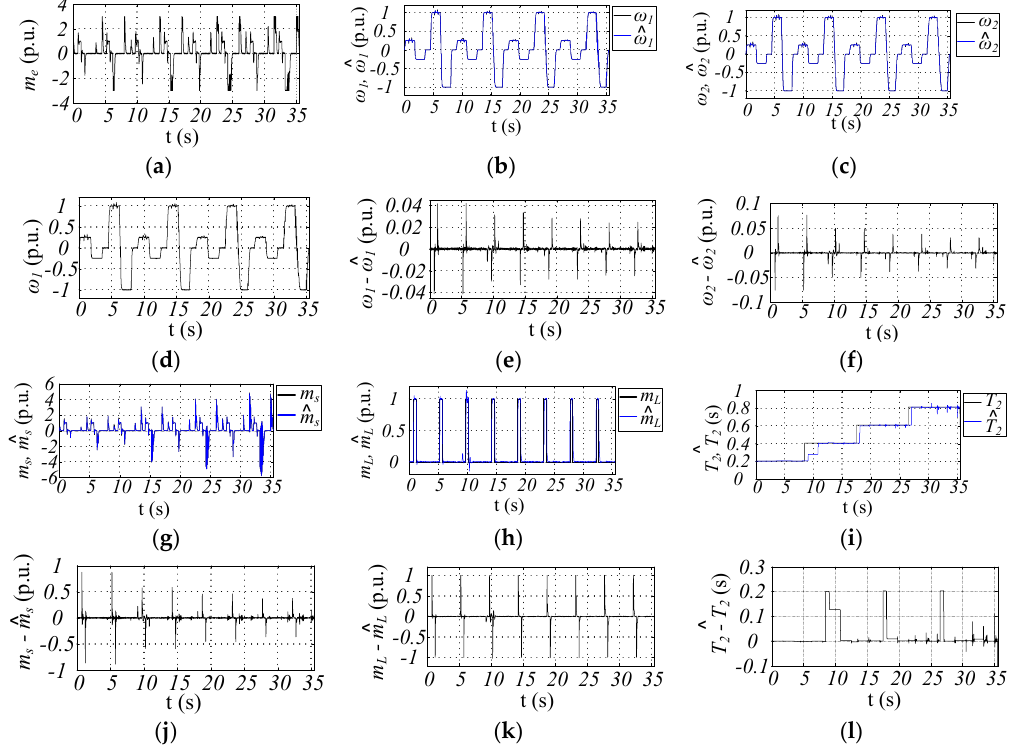
Figure 3. Transients process of the adaptive control structure with the UKF estimator – the simulation results: the electromagnetic load torque ( a ), the angular motor speed ( d ), the actual and estimated variables and it’s estimation errors: the motor angular speed ( b , e ), the load angular speed ( c , f ), the mechanical shaft torque ( g , j ), the mechanical load torque ( h , k ), and the load time-constant of the machine ( i , l )